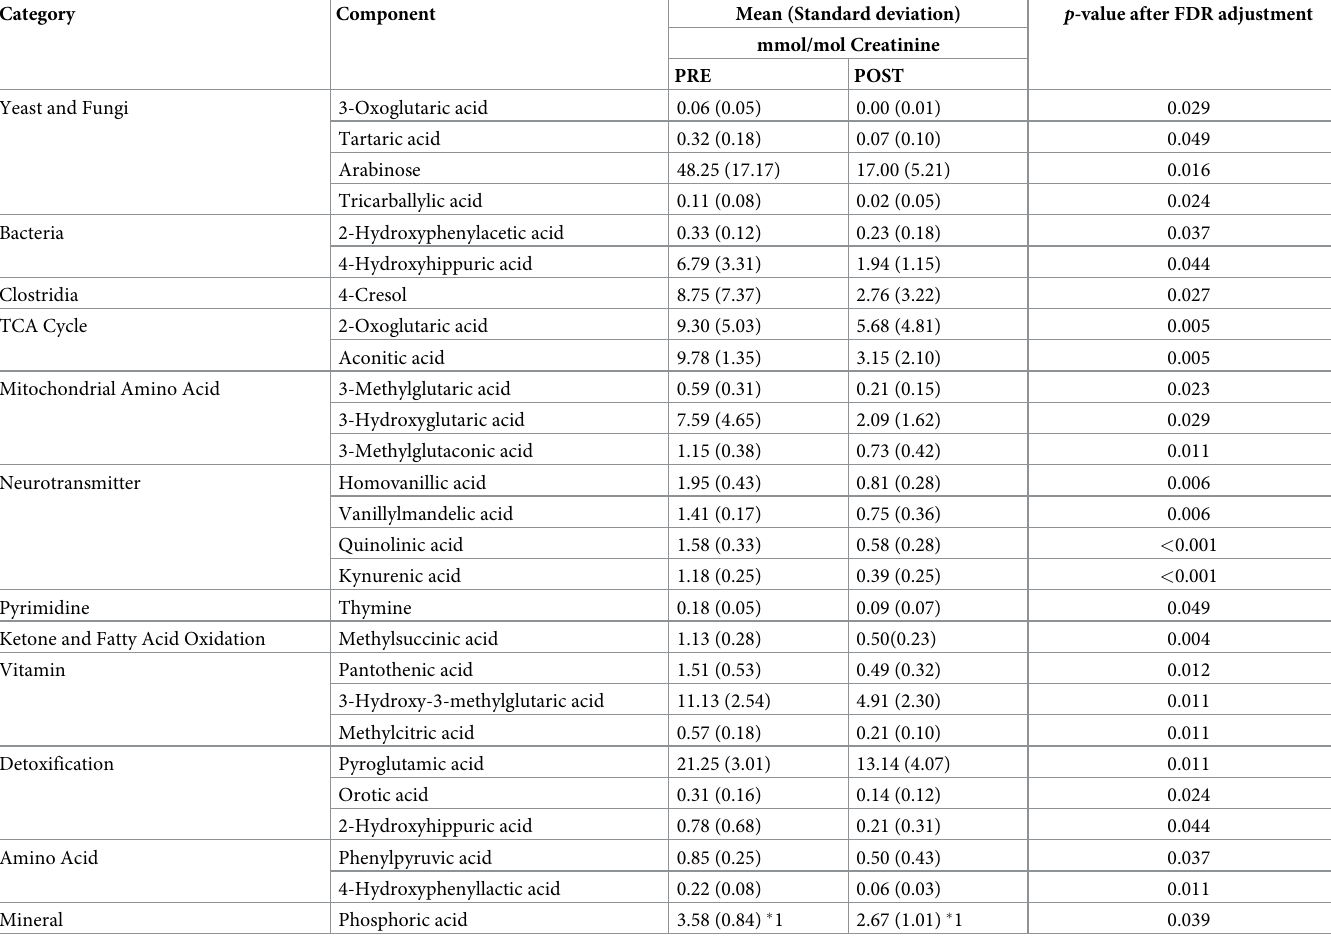
Table 1. Changes in urinary metabolites before and after LEX ingestion; showing only those with significant differences.